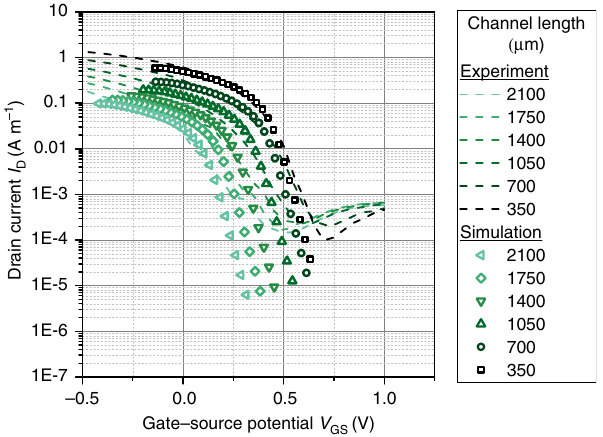
Fig. 8 Transfer characteristic of OECTs. Comparison of experimental transfer characteristics and simulation results for varying channel length. The simulation parameters are shown in Supplementary Table